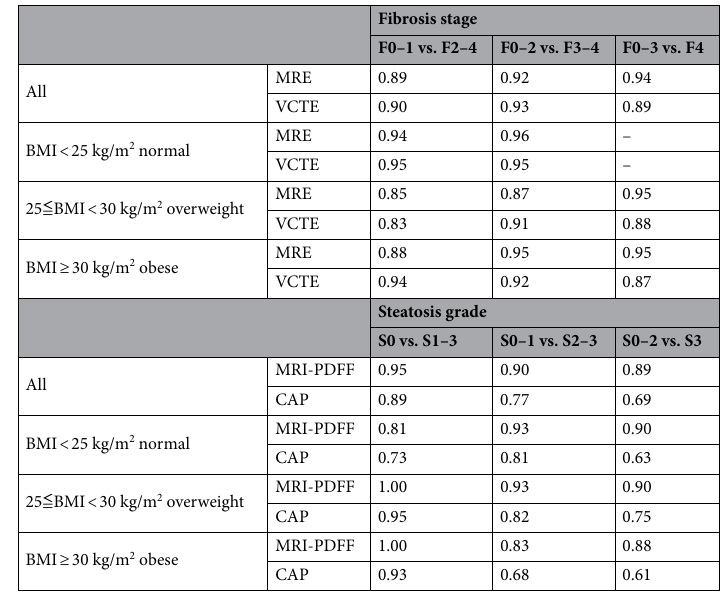
Table 2. Diagnostic ability of VCTE and MRI/MRE techniques to detect hepatic fibrosis and steatosis presented by AUROCs in patients with NAFLD. CAP controlled attenuation parameter, MRE magnetic resonance elastography, MRI-PDFF magnetic resonance imaging-proton density fat fraction, VCTE vibration- controlled transient